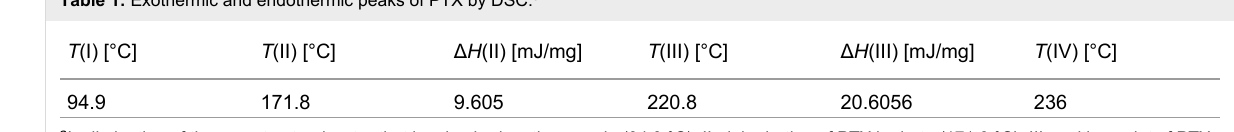
Table 1: Exothermic and endothermic peaks of PTX by DSC. a